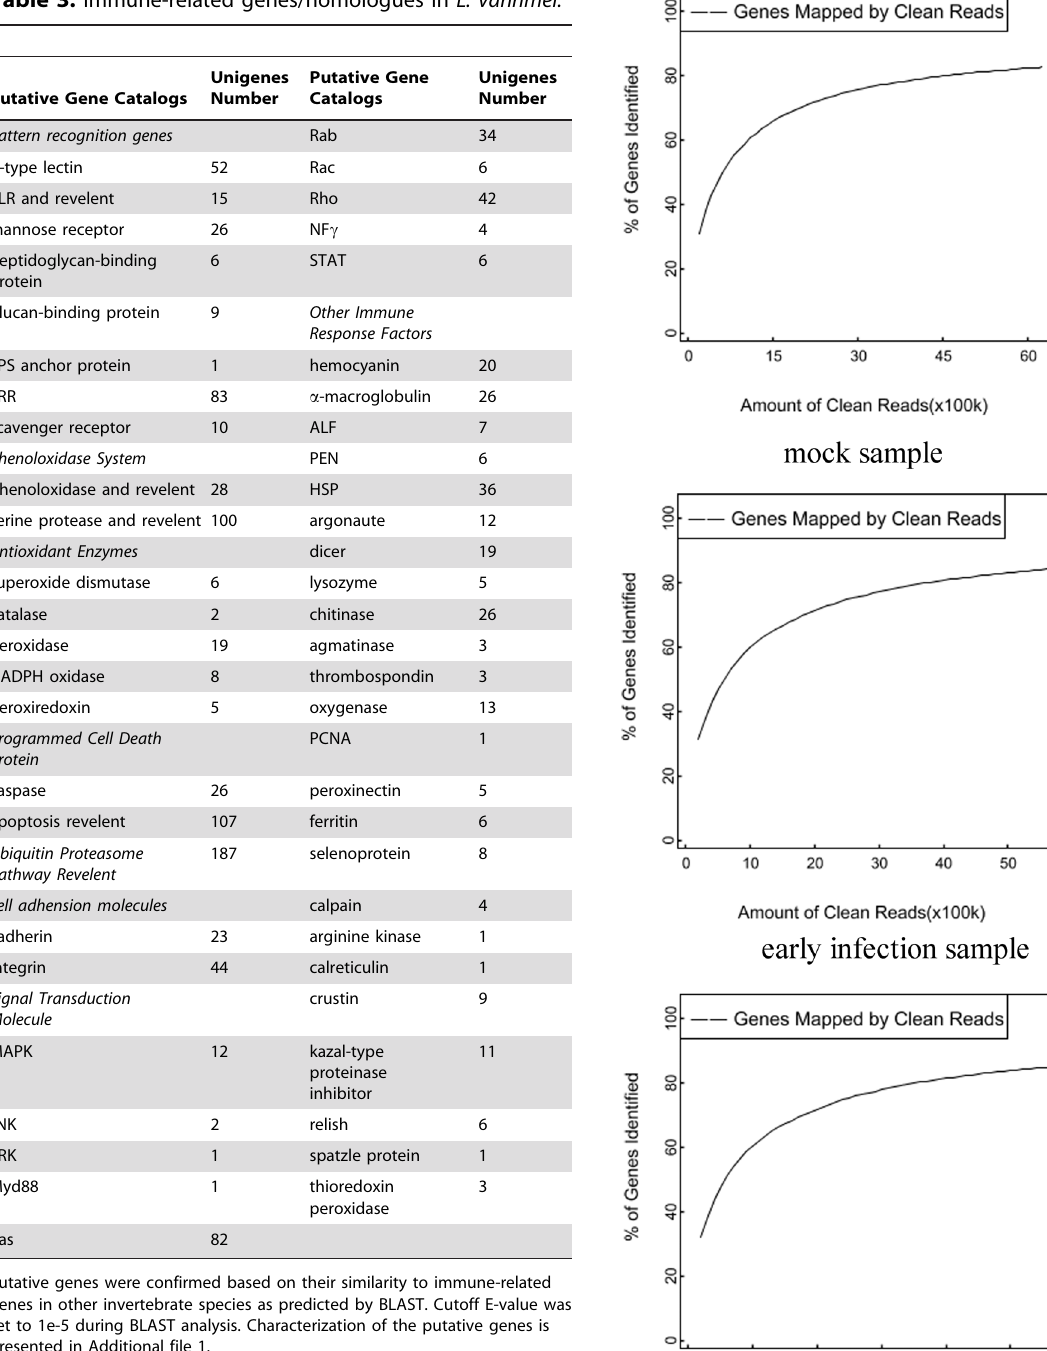
Table 3. Immune-related genes/homologues in L. vannmei.